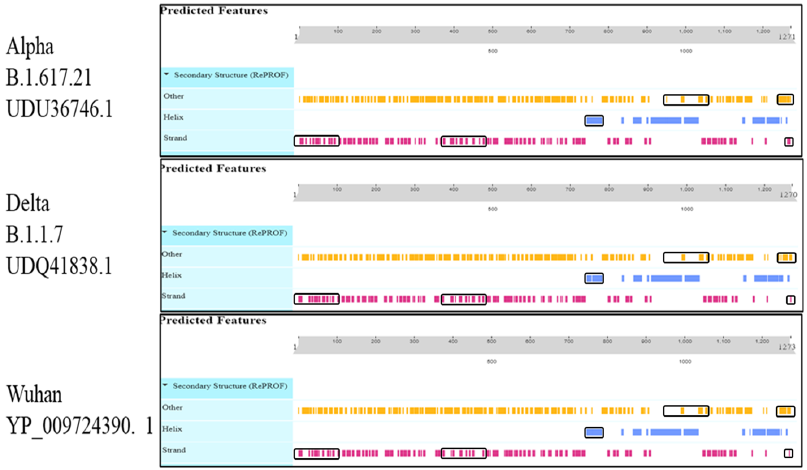
Table 1. Comparison of the secondary structures of the proteins of SARS ‐ CoV strains B.1.617.21 and